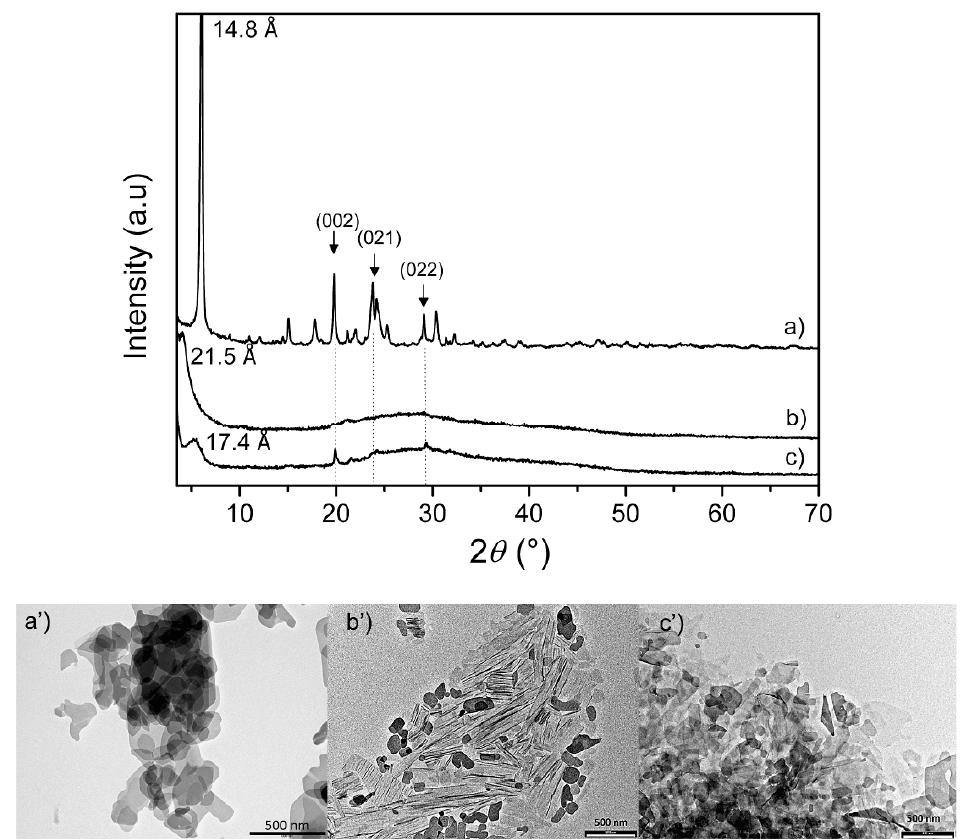
Figure 2. XRPD patterns and TEM images of microcrystalline ZG, ( a , a’ ); centrifuged colloidal dispersion of ZG -MeNH 2 ; ( b , b’ ); centrifuged ZG-e; ( c , c’ ). The numbers in brackets indicate the Miller indices related to the various reflections.